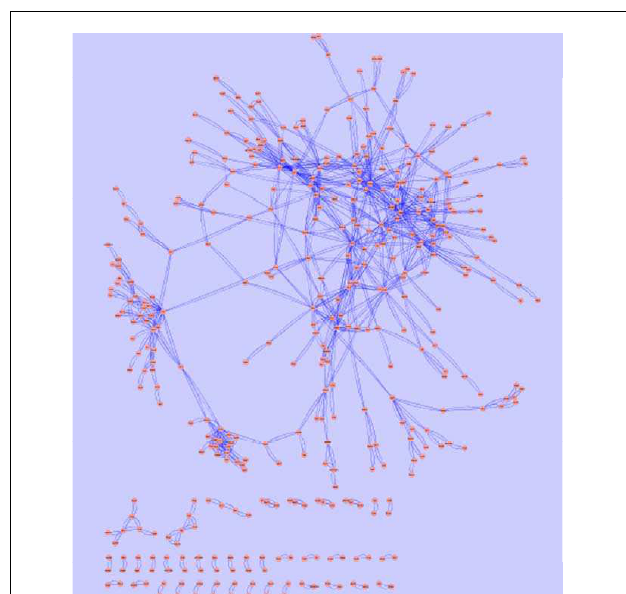
FIGURE 8 |The core genetic network based on gene expression alteration data in the current study was generated using information theory based network modeling approach. Spring-embedded layout was used to demonstrate the arc weights. Graphic representation was generated with Cytoscape (http://www.cytoscape.org).The major network component is consisted of a closely connected kernel layer, a mesh-like intermediate layer, and an outer layer. A small number of distal nodes are separated from the major network component, as displayed at the lower part of the figure.